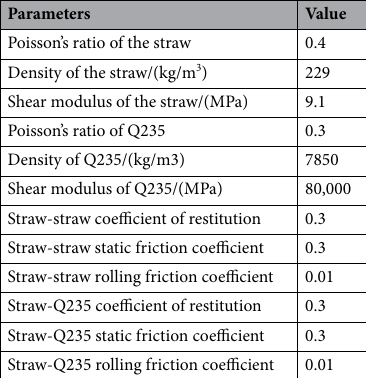
Table 1. Simulation parameters.